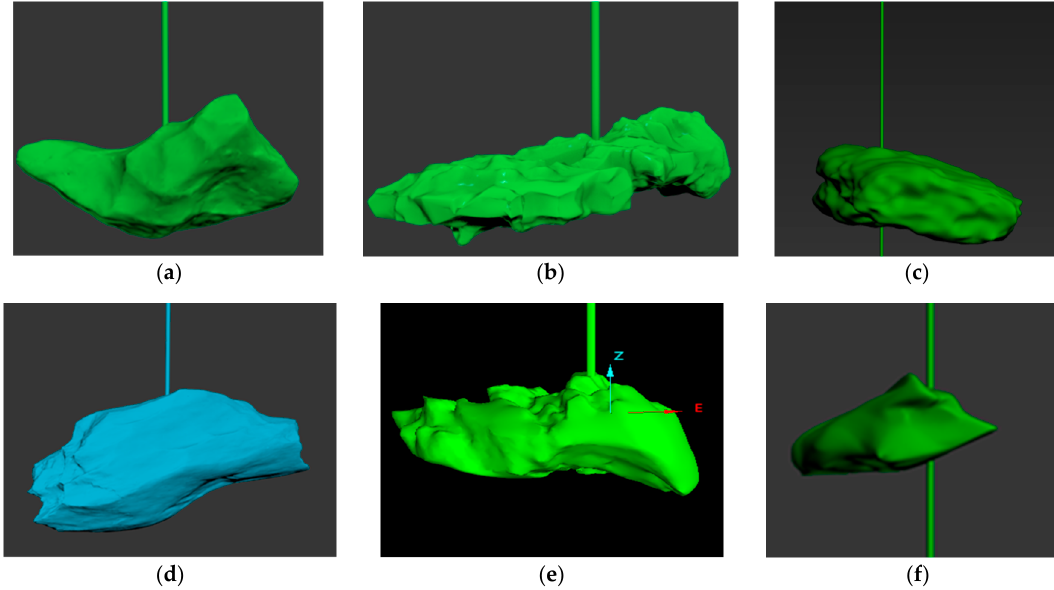
Figure 12. Irregular karst cave model: ( a ) borehole 17#; ( b ) borehole 20#; ( c ) borehole 21#; ( d ) borehole 23#; ( e ) borehole 24#; ( f ) borehole 25#.